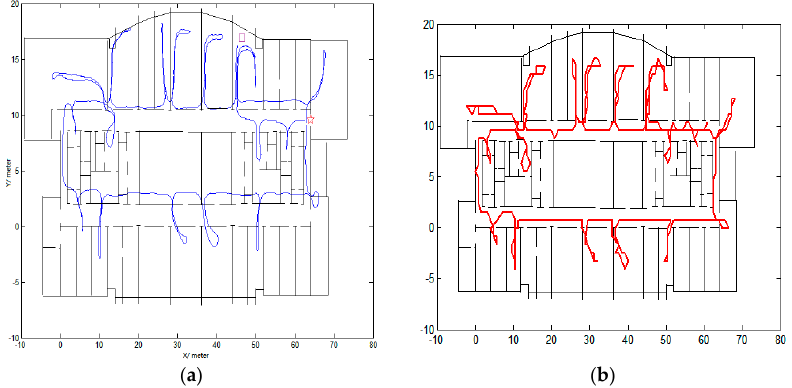
Figure 5. Comparison of trajectory carried out in another site by another person with ( a ) being the raw trajectory and ( b ) being the trajectory using CRFs.